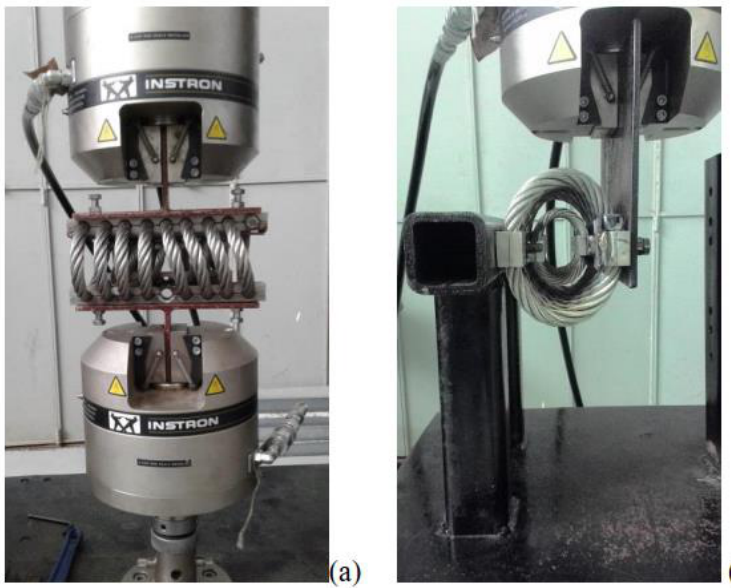
Figure 9. Test setup for cyclic loading of D-WRI: ( a ) vertical and ( b ) roll.